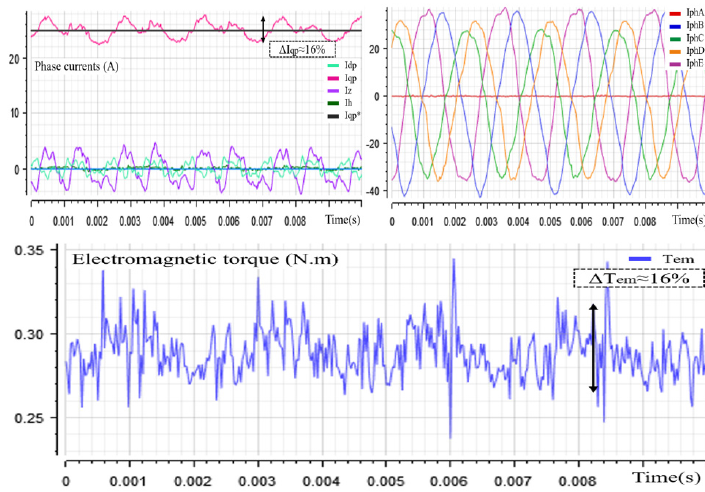
Figure 11. Stator currents and electromagnetic torque in Reconfigured operation.